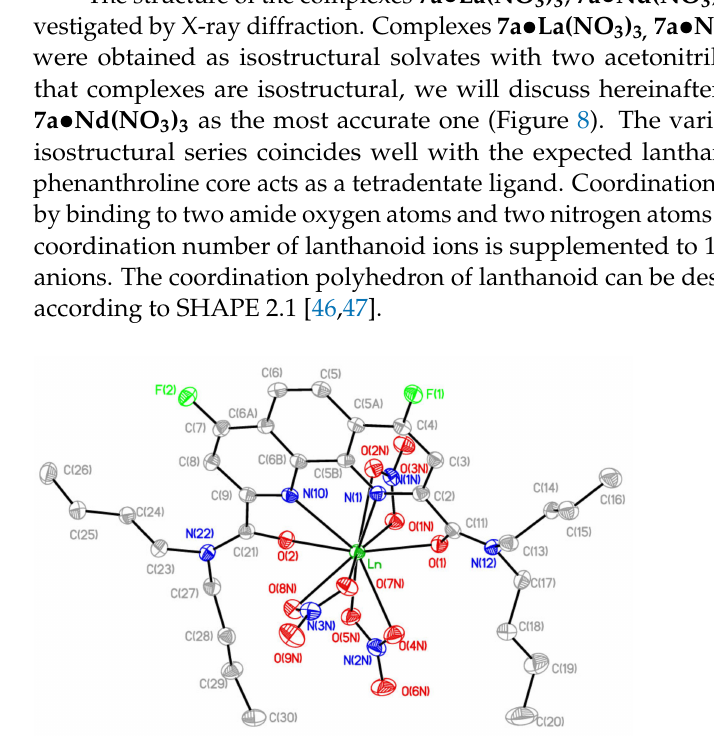
Figure 8. The general view of 7a • Ln(NO 3 ) 3 complexes. The atoms are shown as the ellipsoids of atomic displacement parameters ( p = 50%) for the 7a • Nd(NO 3 ) 3